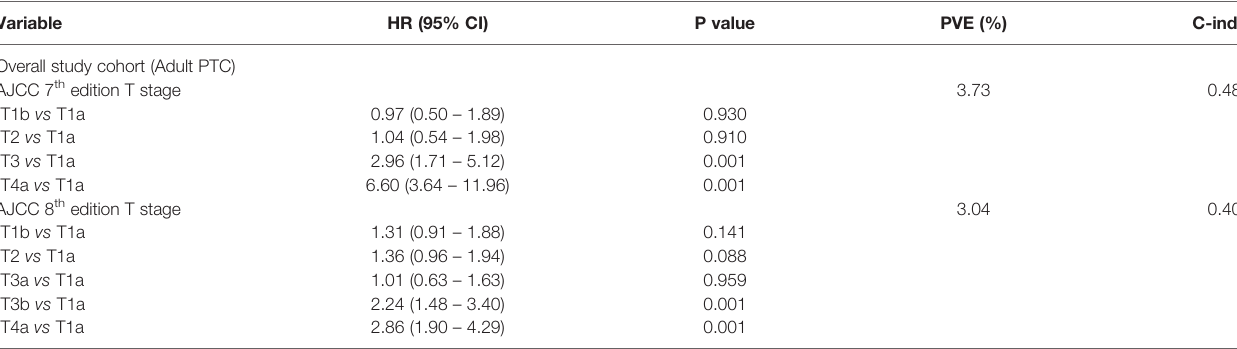
HR, Hazard ratio; CI, Con fi dence interval; PVE, Proportion of Variation Explained; PTC, Papillary Thyroid Carcinoma; AJCC, American Joint Committee on Cancer.